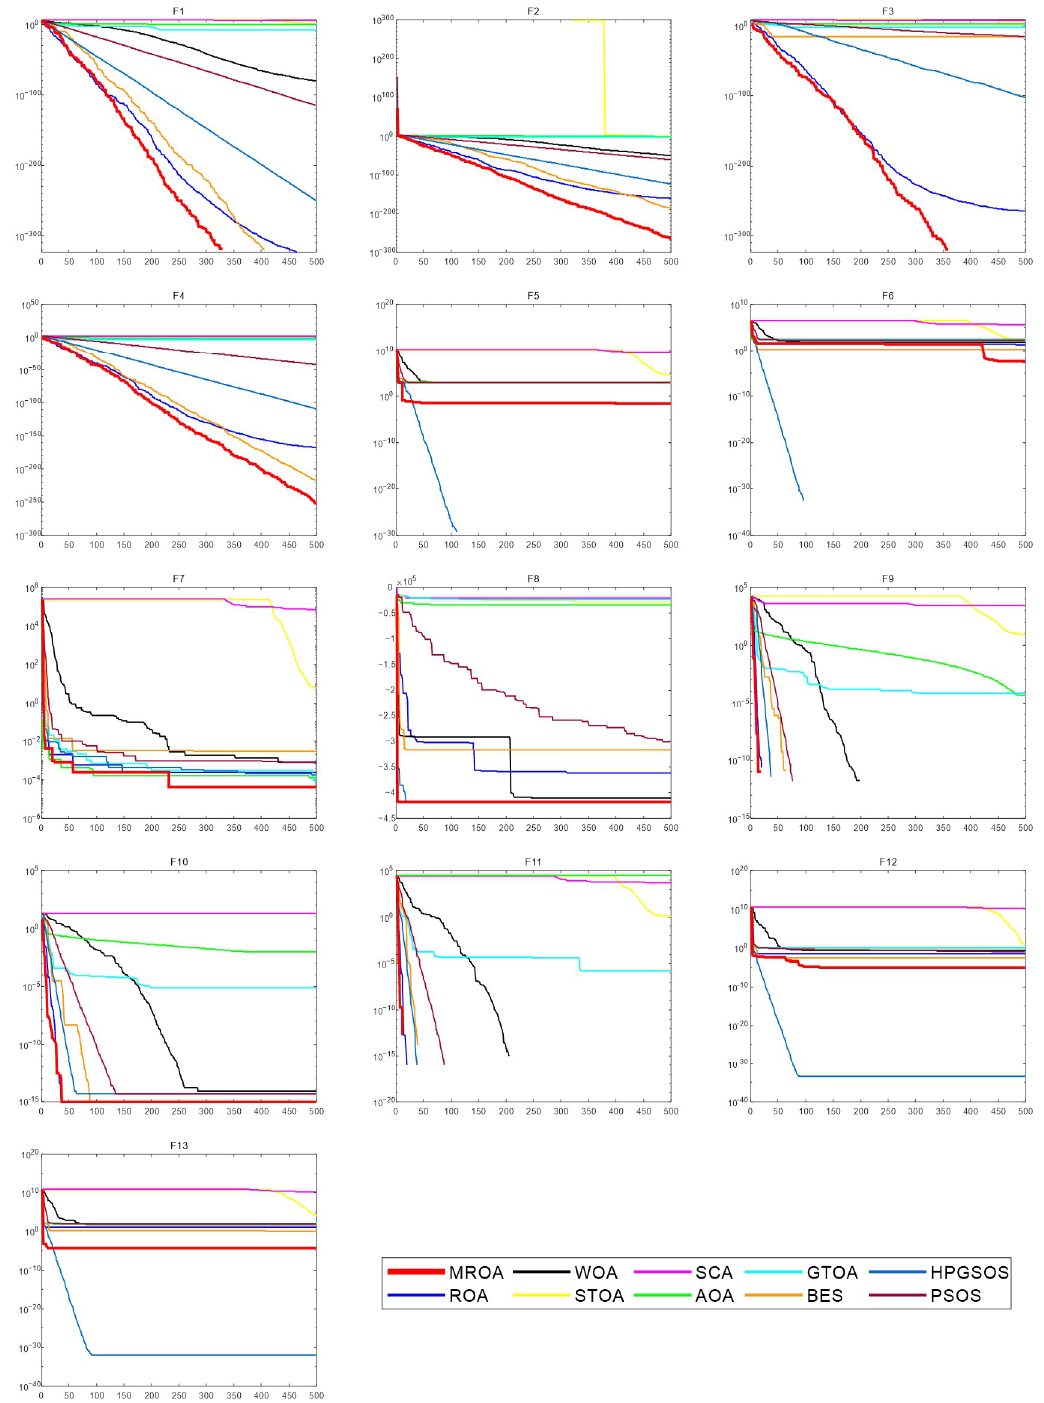
Figure 8. The convergence curves for the optimization algorithms on test functions (F1–F13) with dim = 1000.